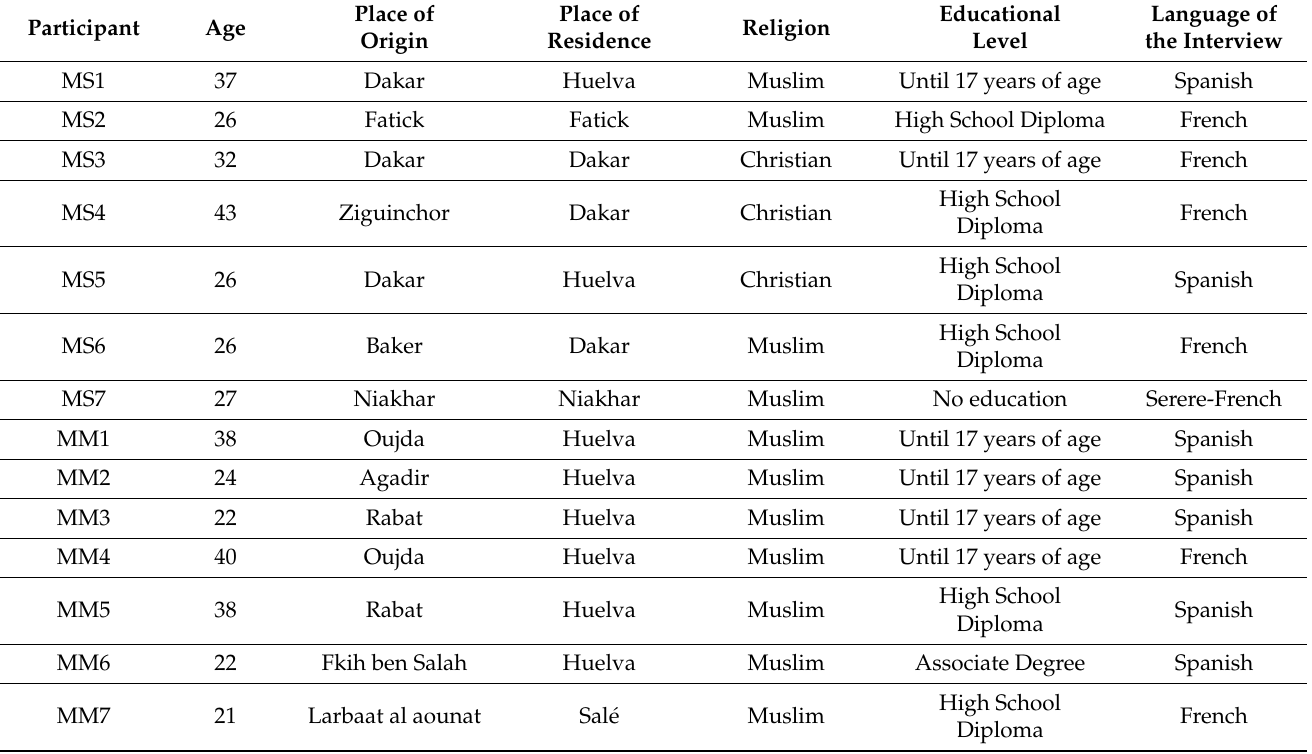
Table 3. Participants’ sociodemographic